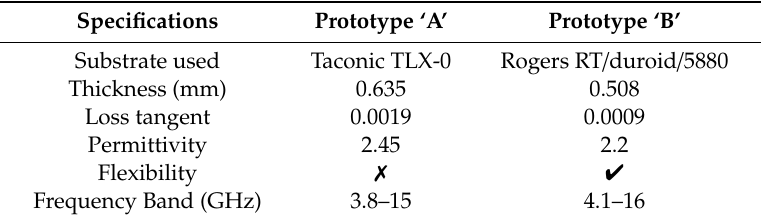
Table 1. Comparison analysis with two laminates.